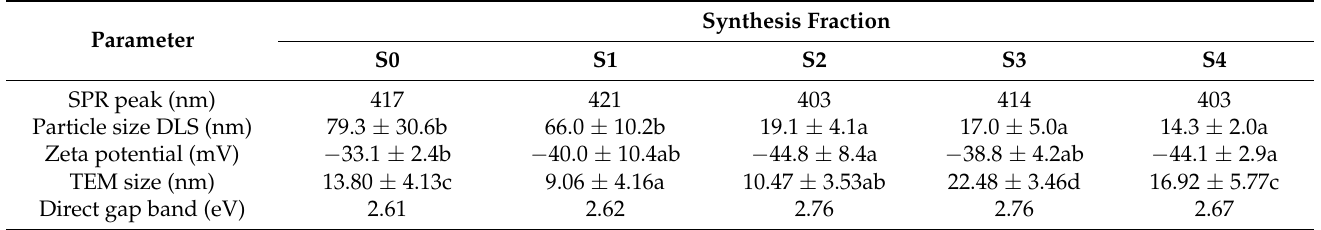
Table 1. Characterization of the AgNPs obtained using different mycelia-free aqueous extract fractions. Synthesis Fraction Parameter